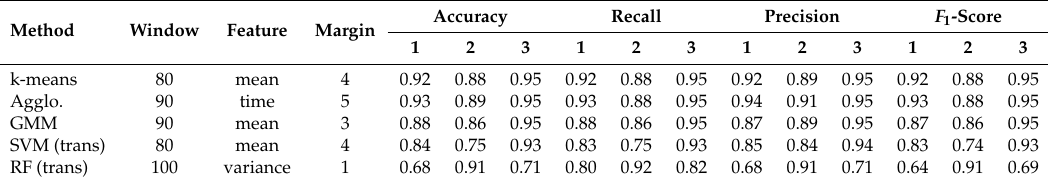
Table 4. Top scoring parameter combinations over all datasets (1/2/3) per method. The results show that these combinations have high scores for all datasets, not just individual experiments (the feature extraction window is the number of samples (@50Hz); the extracted feature is mean, variance or time (time = mean/var/range/median); the transition scoring margin is the number of samples) (datasets numbered as listed in Section 4).